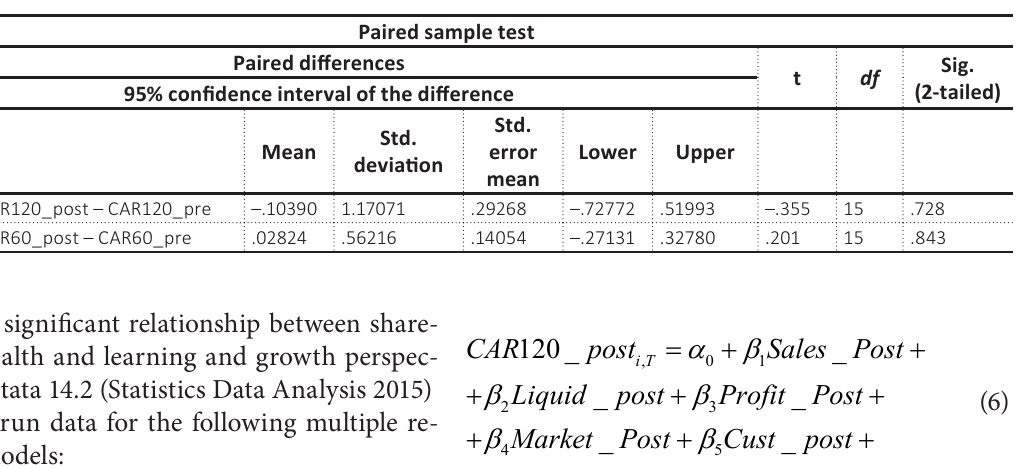
Table 4. T-test for comparison between pre- and post-CAR 120 days and pre- and post-CAR 60